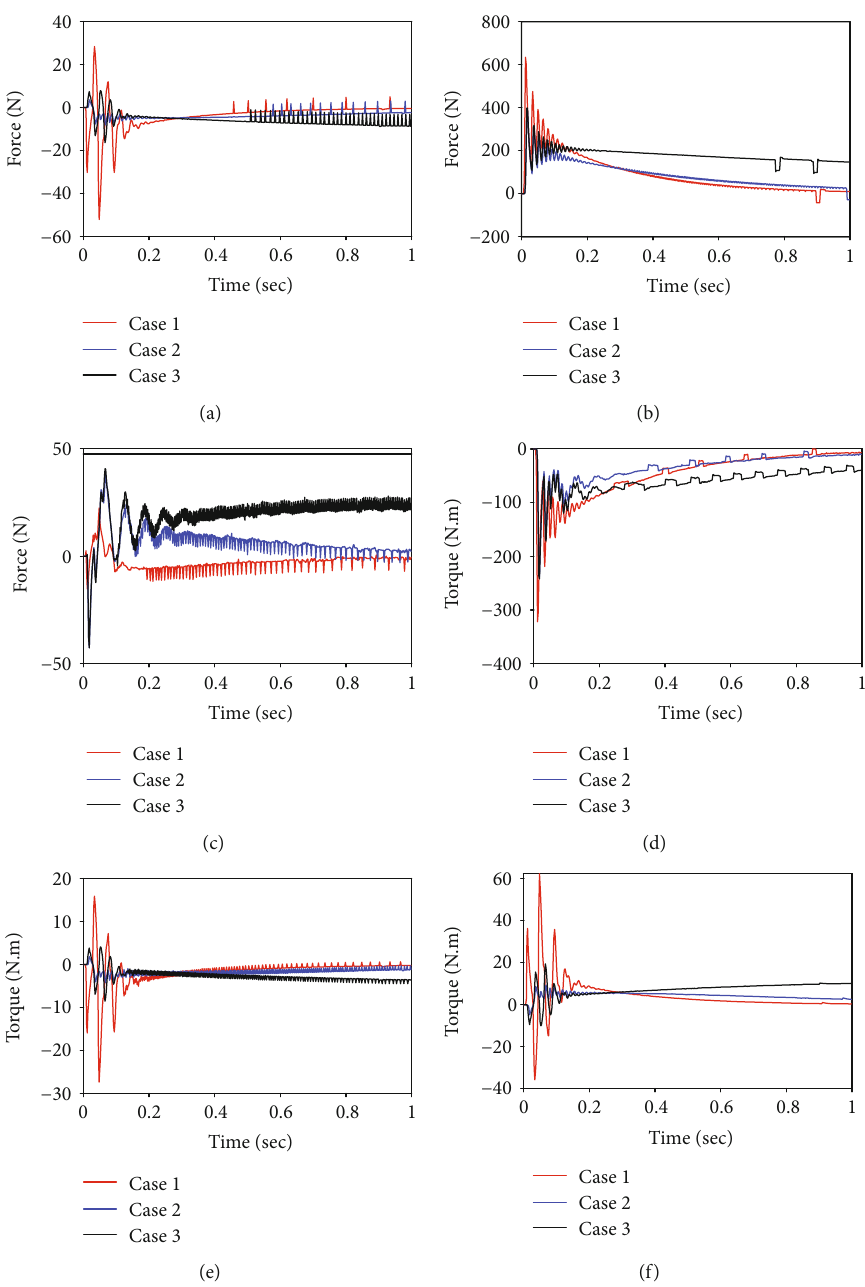
Figure 22: Control force and torque on the base of the space robot: (a) force in X axis, (b) force in Y axis, (c) force in Z axis, (d) torque about X axis, (e) torque about Y axis, and (f) torque about Z